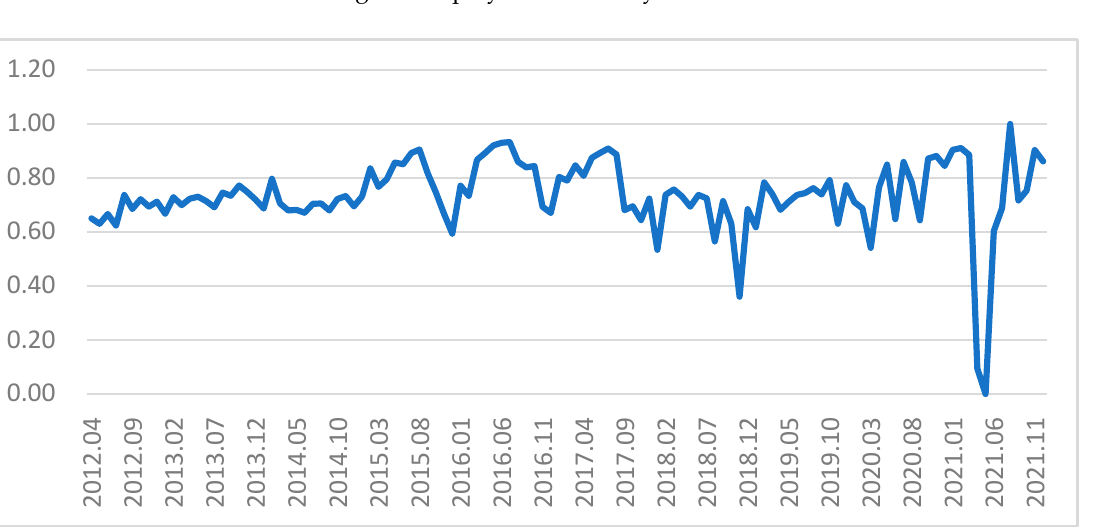
Figure 3. Crisis Index Trend in the Coke and Briquettes Industry.